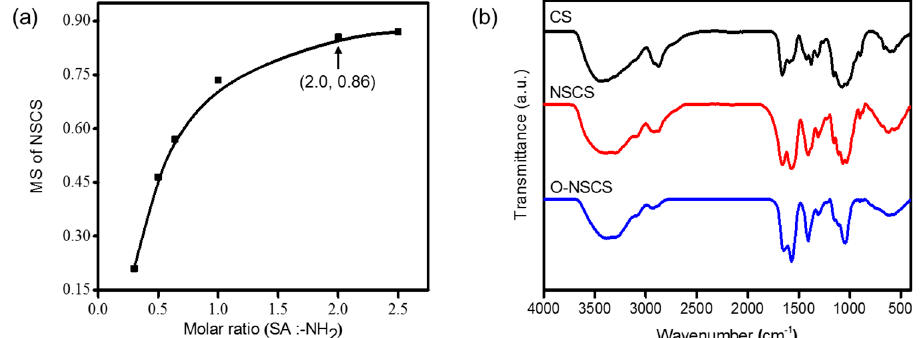
Figure 1. ( a ) Effect of the molar ratio of reactants on the molar substitution (MS) of NSCS. ( b ) FTIR spectra of chitosan (CS), NSCS, and 6-oxidized N -succinyl chitosan